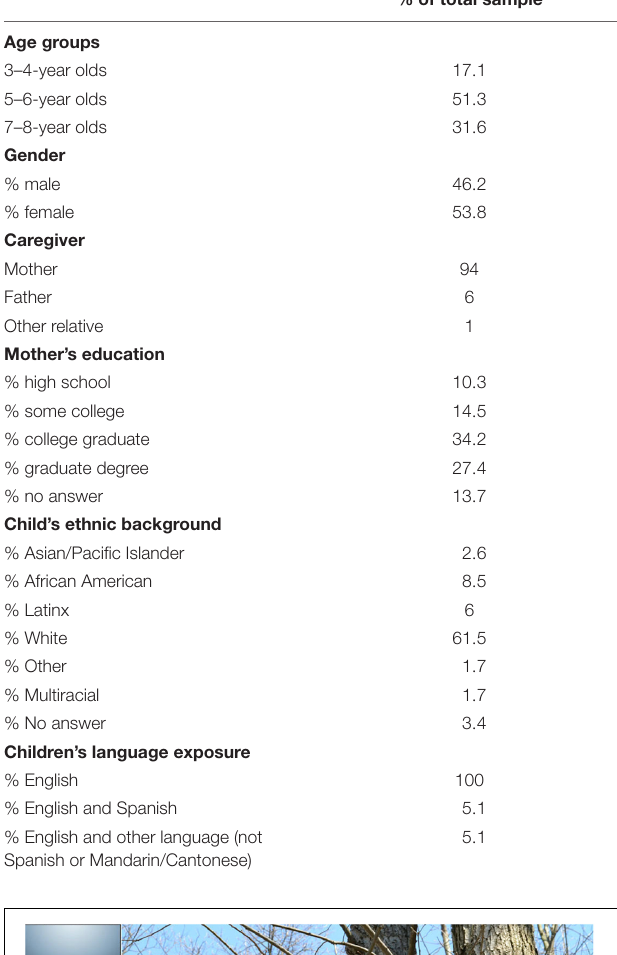
TABLE 1 | Demographics of the sample.